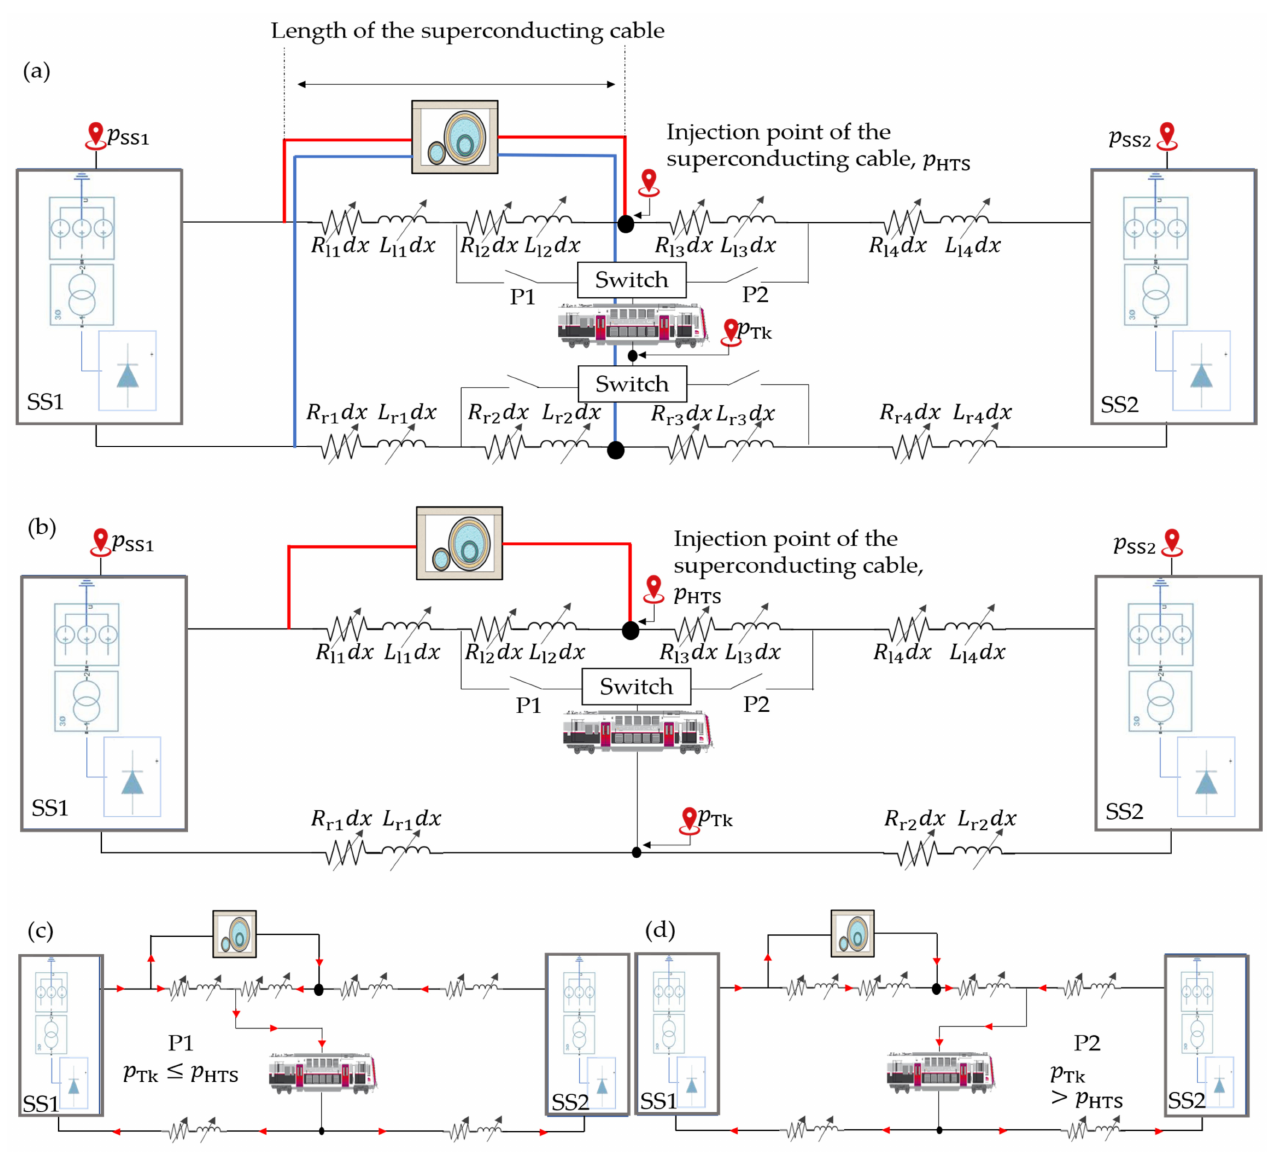
Figure 12. Diagram of the different impedances of a typical traction line ( a ) with a bipolar cable, ( b ) with a unipolar cable. ( c , d ) provide the current direction for the two possible positions (P1 and P2) of the train compared to the injection point for a unipolar cable. The positions P1 and P2 define two circuits depending on the relative position of the train to the injection point. In order to simplify the explanation, we represent those positions by two switches named P1 and P2, as shown